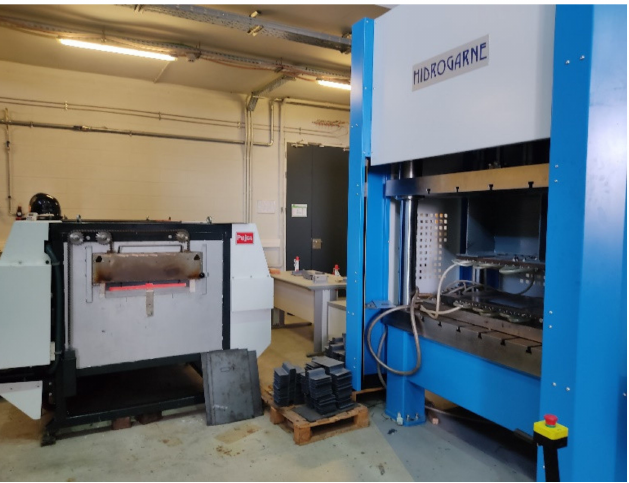
Figure 2. The pilot plant at Eurecat Manresa from which is defined the experiment considered in simulation and